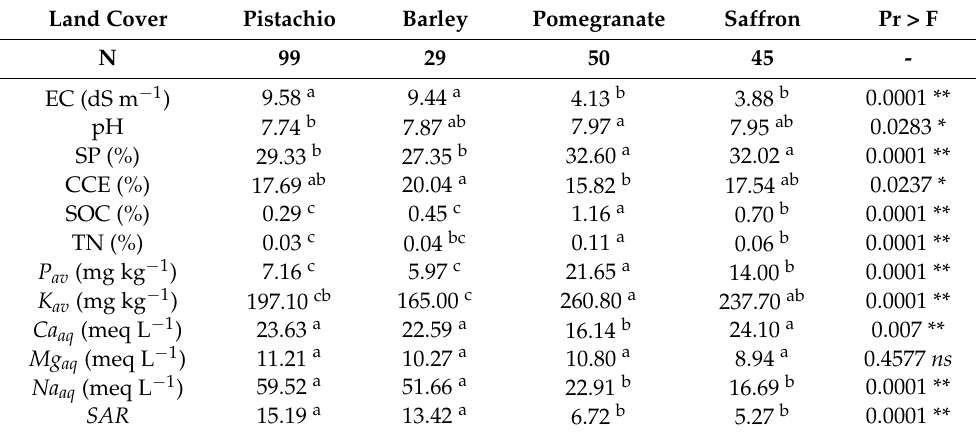
Table 3. Comparison of the mean values of soil properties through different cultivated lands. Land Cover Pistachio Barley Pomegranate Saffron